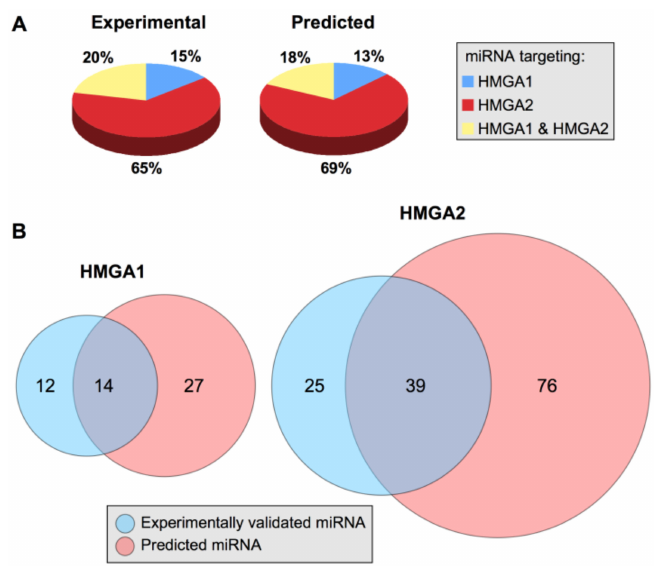
Figure 4. An overview of HMGA1- and HMGA2-targeting miRNAs. ( A ) Comparison of the percentage distributions of experimentally validated and predicted HMGA1- and HMGA2-targeting miRNAs. ( B ) Venn diagrams of experimentally validated and predicted miRNAs targeting HMGA1 and